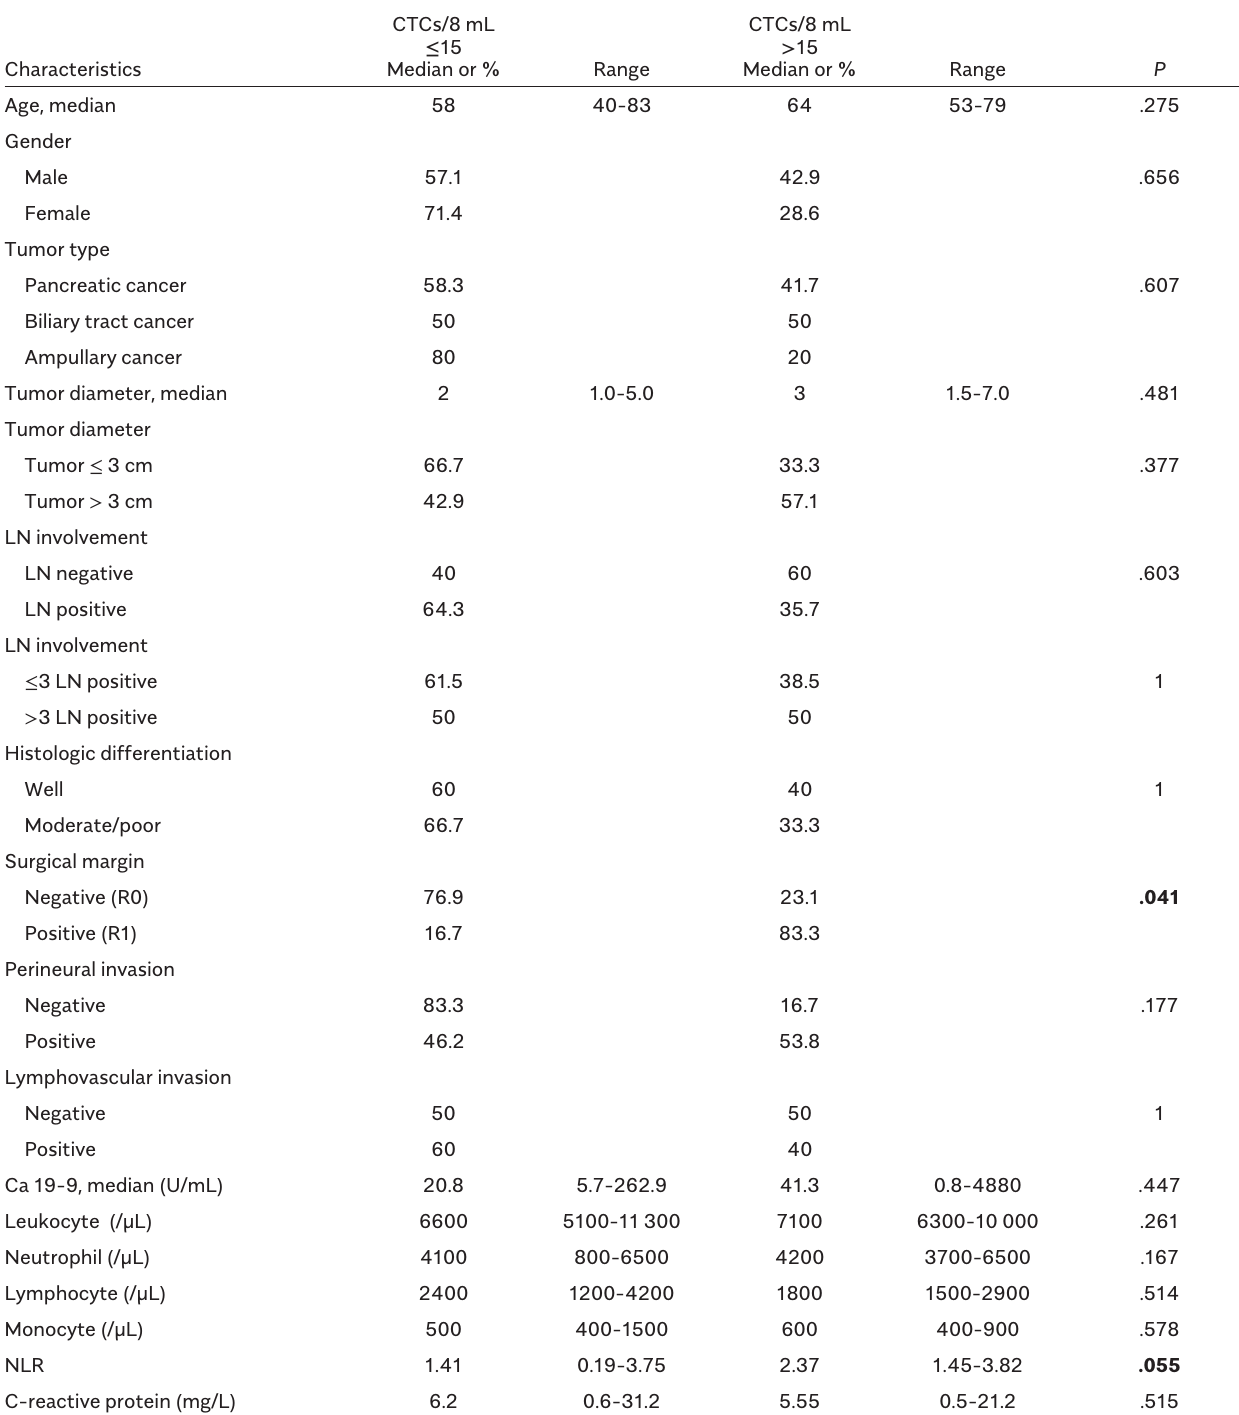
Table 3. Relationship Between CTC Status and Clinicopathological Characteristics